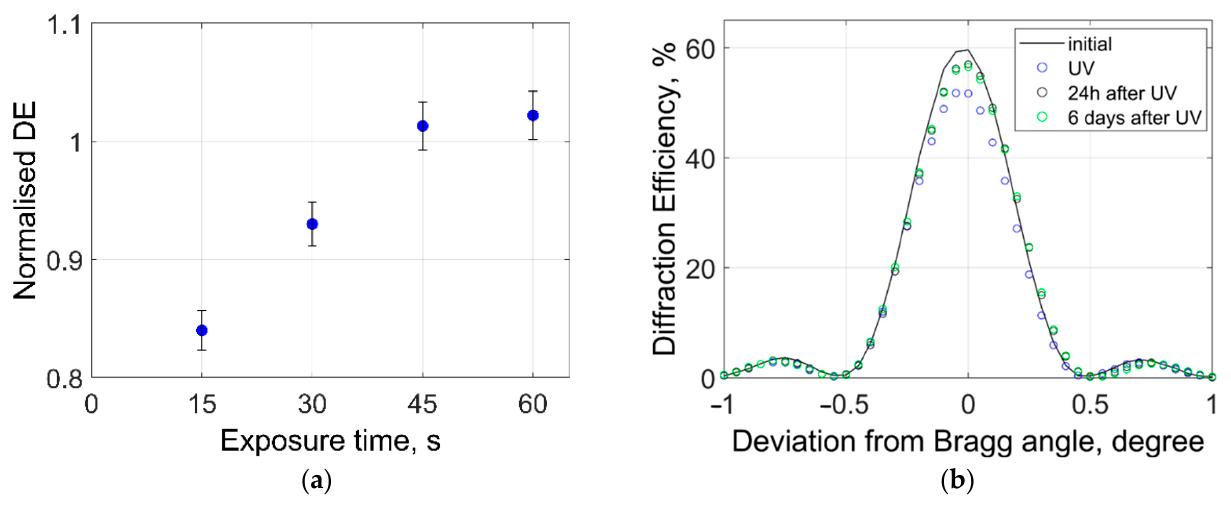
Figure 5. ( a ) Normalised diffraction efficiency (DE) versus the exposure (recording) time shows the effect of UV-curing on the grating fixation. Normalised diffraction efficiency was calculated as the ratio of the diffraction efficiency obtained after UV-curing and after recording; ( b ) Bragg selectivity curves of the transmission grating recorded using 30 s exposure demonstrate stability of the diffraction efficiency after UV-curing.